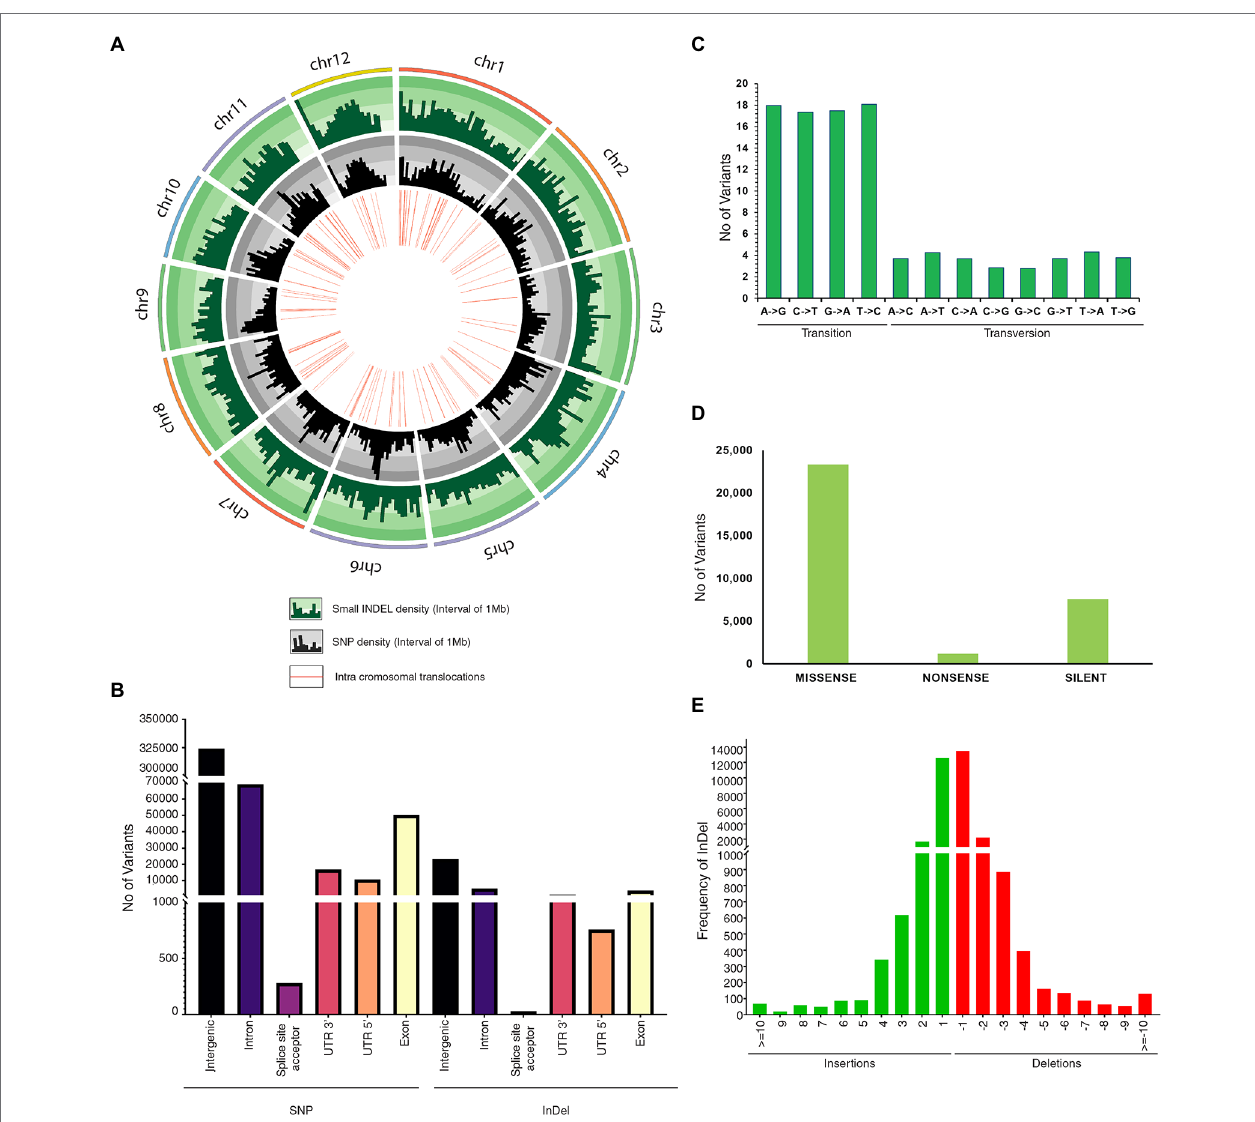
FIGURE 2 | Genetic variation in JBT 36/14 compared to reference indica genome; (A) Circos diagram of genome wide variations depicting InDel density, SNP density and intrachromosomal translocations; (B) Annotation of SNPs and InDels by location; (C) Type of SNP variants by base substitution in JBT 36/14 genome; (D) Functional annotation of SNP variants; and (E) Size distribution of identified InDels in JBT 36/14